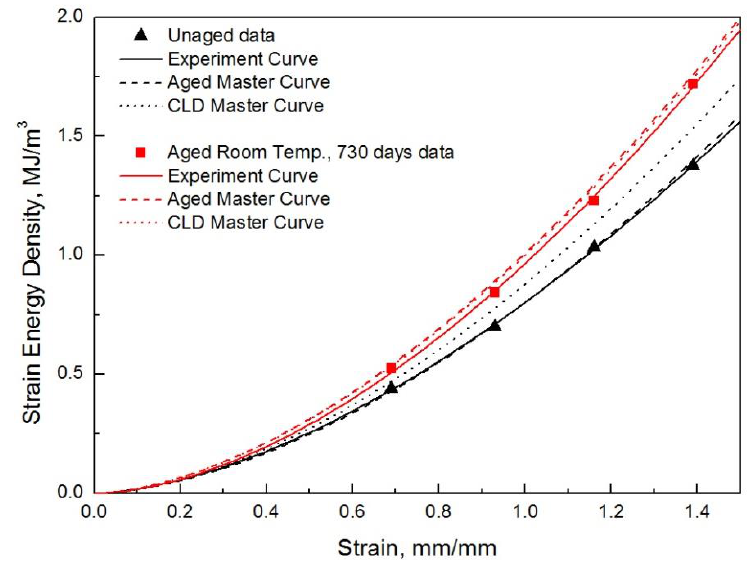
Figure 4. Master curve and validation. Table 6. Comparison of SED values according to experimental and aged master curves. Aging Condition Strain Predicted SED Test SED